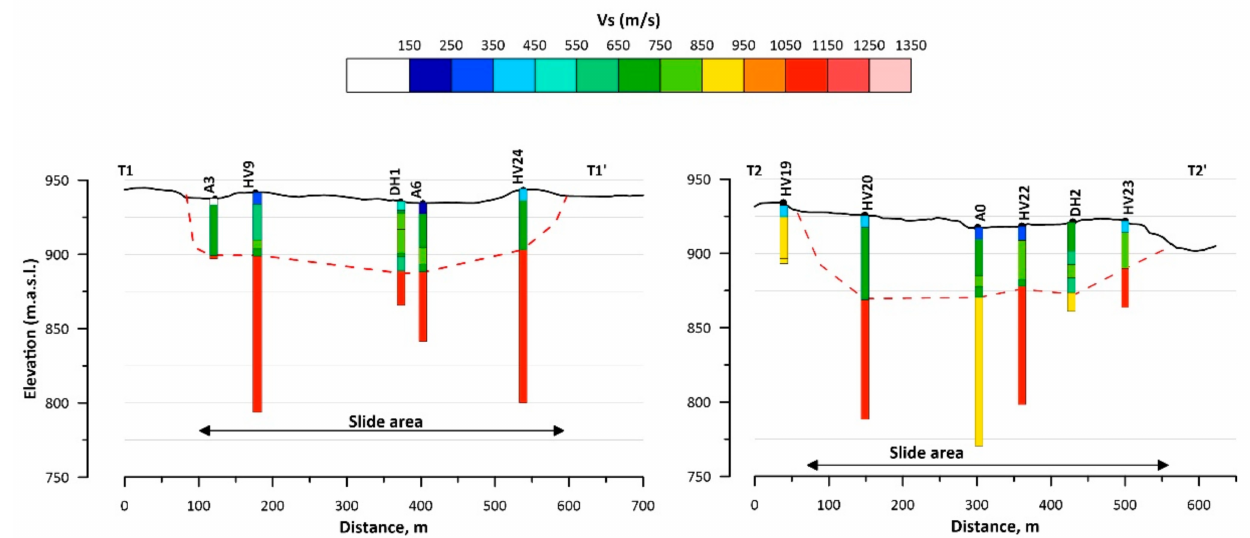
Figure 10. Transversal cross sections of the landslide. See Figure 3 for location of